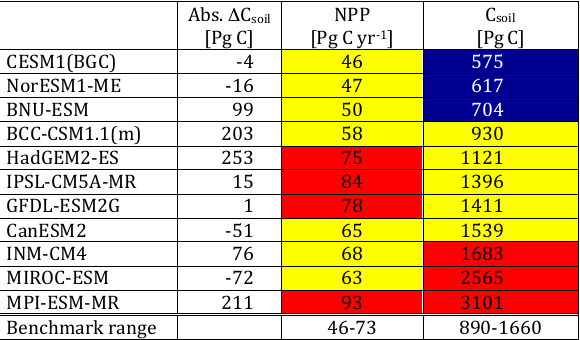
Figure!4:!Metrics!of!ESM!performance!and!benchmarks!for!soil!C!change!(difference!in!103 Fig. 4. Metrics of ESM performance and benchmarks for soil year!means,!209032099!minus!199732006),!net!primary!production!(NPP;!103year!mean!19973 C change (difference in 10-year means, 2090–2099 minus 1997– 2006), net primary production (NPP; 10-year mean 1997–2006), 2006),!and!modern!soil!carbon!pools!(103year!mean!199732006).!Benchmark!data!are!shown!in! and modern soil carbon pools (10-year mean 1997–2006). Bench- mark data are shown in the bottom row. Blue cells indicate the!bottom!row.!Blue!cells!indicate!ESM!outputs!that!fall!below!the!benchmarks,!yellow!cells!are! ESM outputs that fall below the benchmarks, yellow cells are consistent!with!benchmarks,!and!red!cells!are!above!the!benchmarks.!NPP!data!are!from!Ito! consistent with benchmarks, and red cells are above the bench- marks. NPP data are from Ito (2011); modern soil carbon (2011);!modern!soil!carbon!stocks!are!from!Todd3Brown! et#al. !(2013)!and!originally!from! stocks are from Todd-Brown et al. (2013) and originally from (FAO/IIASA/ISRIC/ISSCAS/JRC, 2012). (FAO/IIASA/ISRIC/ISSCAS/JRC,!2012).